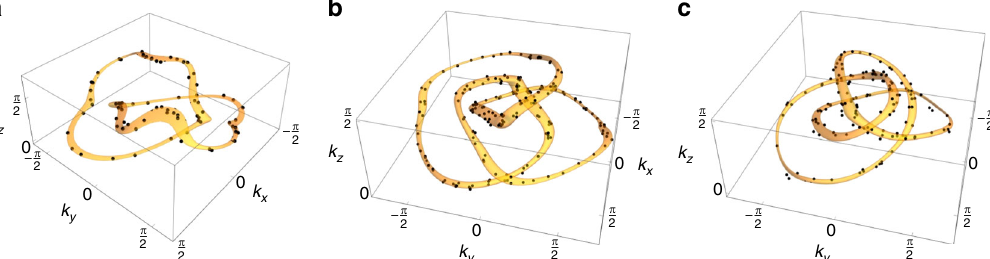
Fig. 3 Simulated nodal structure measurements under PBCs. Points in reciprocal space corresponding to admittance eigenvalues smaller than a threshold j s are colored black, which collectively delineate their theoretically computed respective nodal links or knots (orange). a Two entangled unknots, de fi ned as the Hopf-link. The black dots combine the simulation results with circuit dimensions of 22 ´ 22 ´ 16